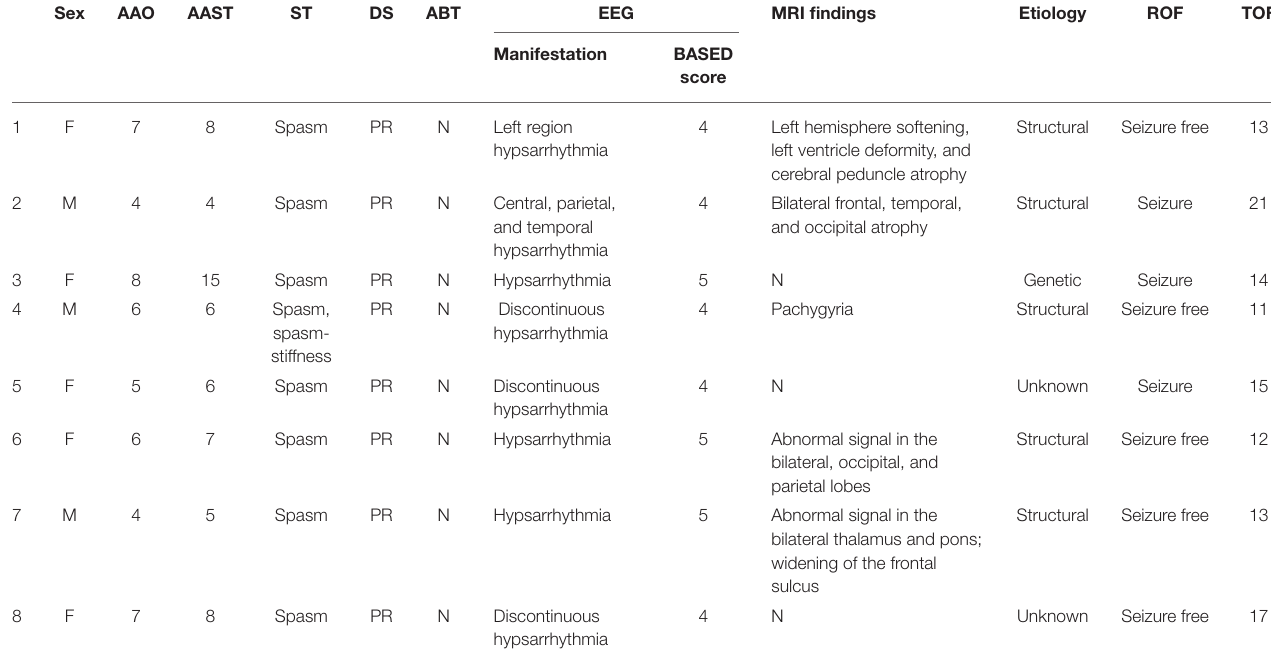
TABLE 1 | Subjects’ demographics and clinical data.